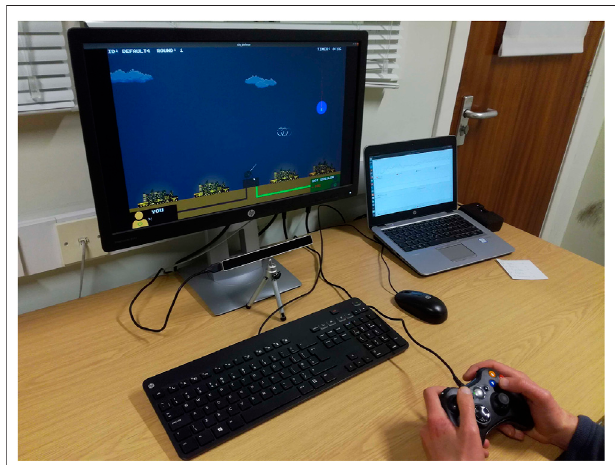
FIGURE 4 | Picture of the experimental setup used during the study. Participants took part in the experiment in a quiet lab, using a Xbox360 controller and playing on a 24 ″ 1920 × 1,080